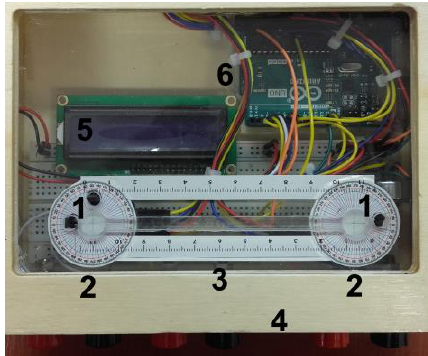
Fig. 2. A view of the prepared stand with marked components: 1 - Hall sensor, 2 - angular scale, 3 - linear scale, 4 - laboratory terminals, 5 - display, 6 - Arduino Uno with